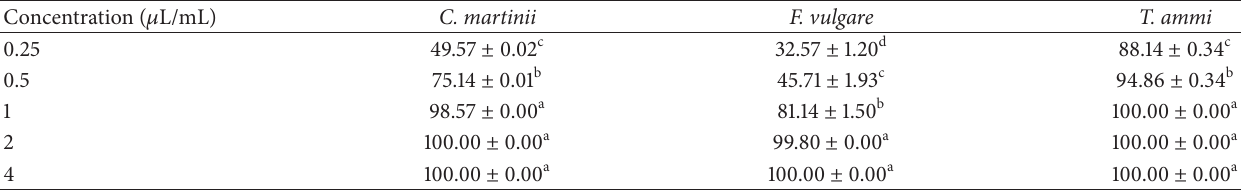
Table 3: Percent of spore germination inhibition of toxigenic Aspergillus flavus by essential oils using fungal spore germination assay. Concentration ( 𝜇 L/mL)